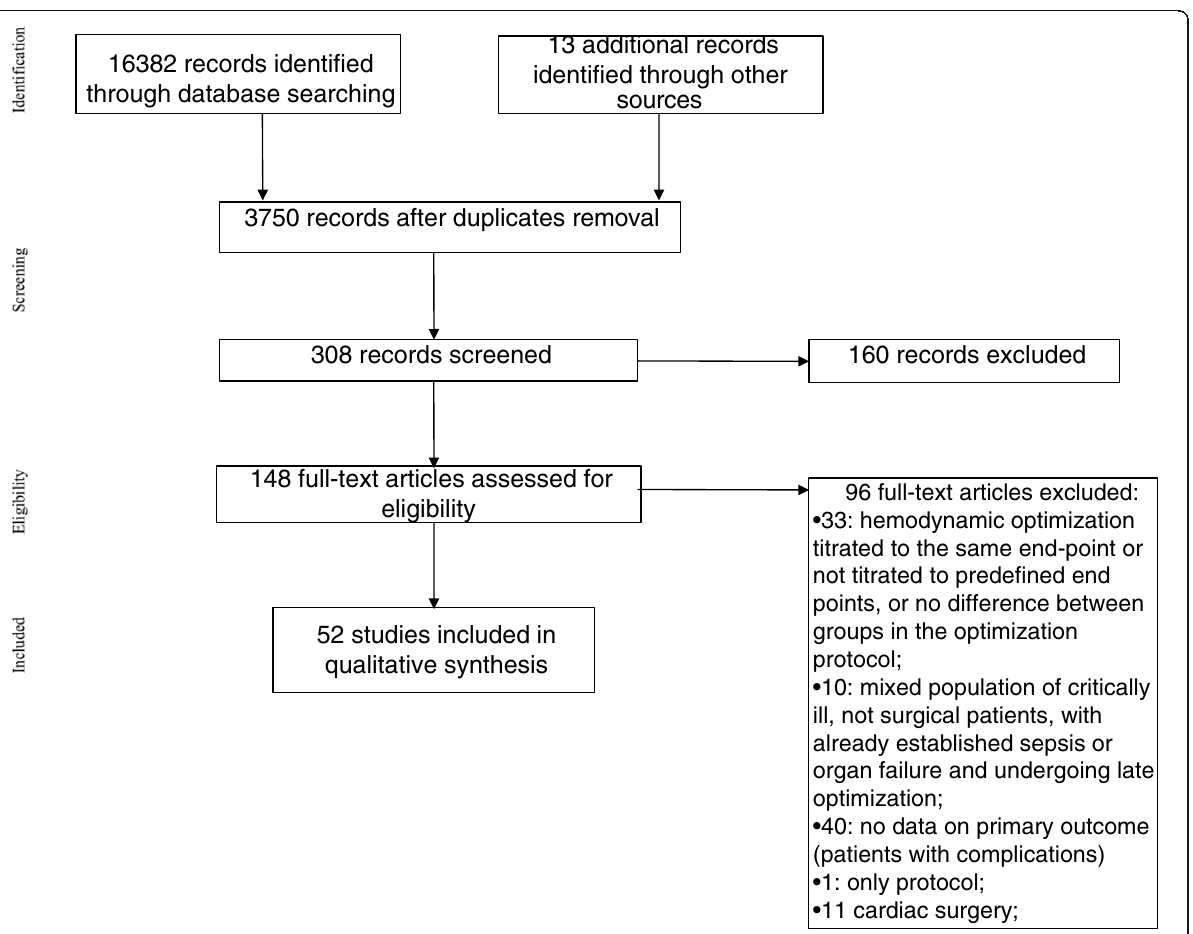
Fig. 1 Flow chart summarizing the studies selection procedure for the meta-analysis. RCT, andomized controlled